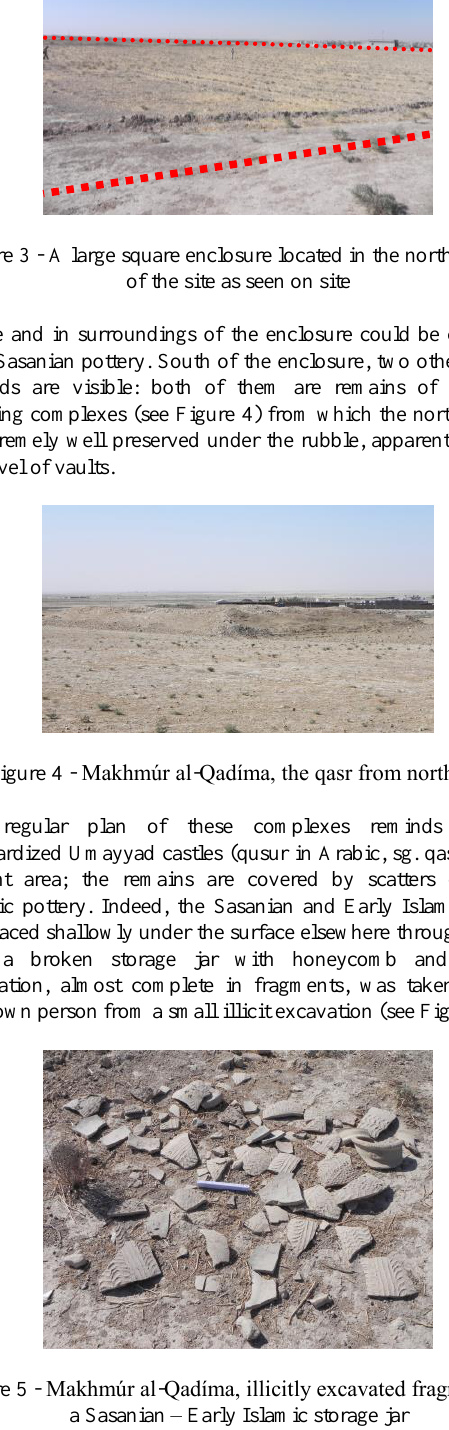
Figure 5 - Makhmúr al-Qadíma, illicitly excavated fragments of a Sasanian – Early Islamic storage